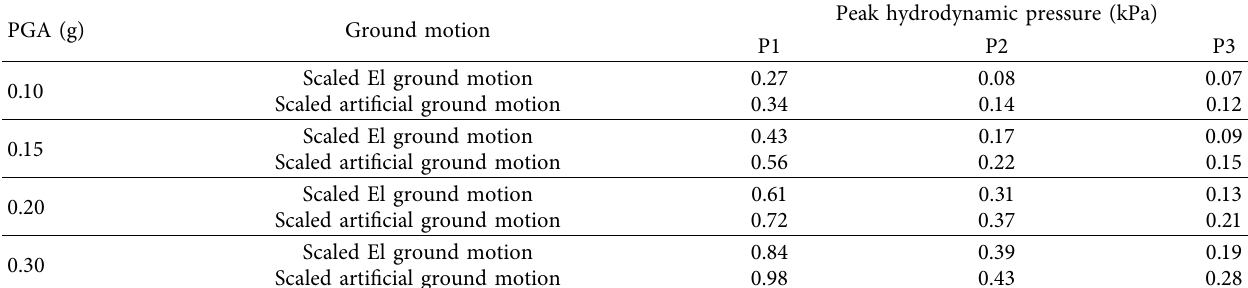
Table 9: Statistics of peak hydrodynamic pressure.